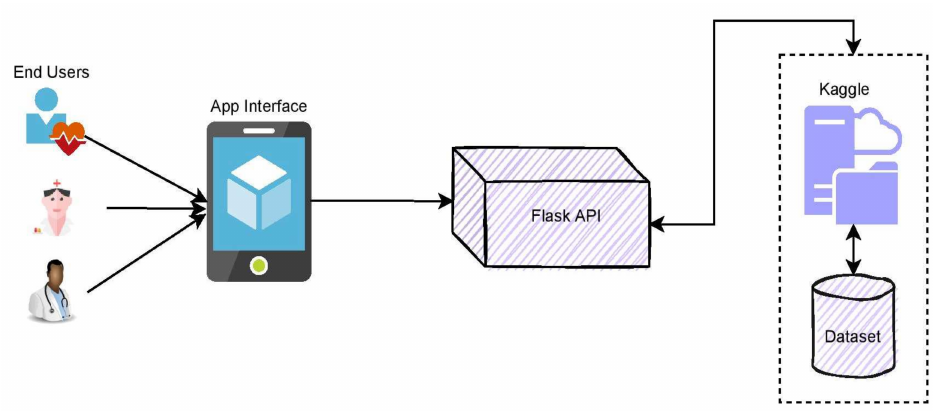
Figure 16. Block diagram of practical implication